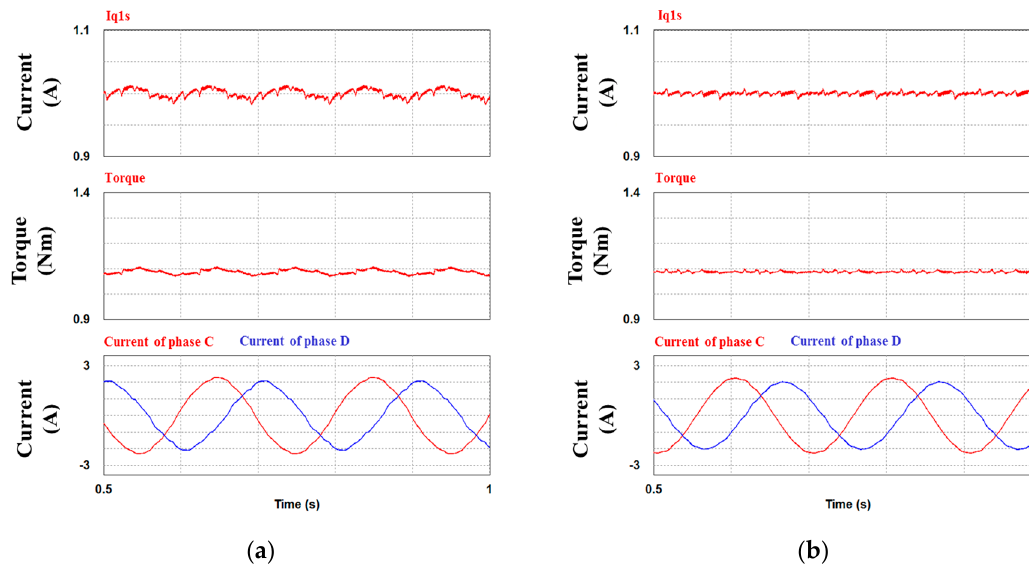
Figure 10. Simulation result of fault ‐ tolerant control under open fault phases B in i q1s = 1 A and 300 rpm: ( a ) Without tolerant control; ( b ) With tolerant control.